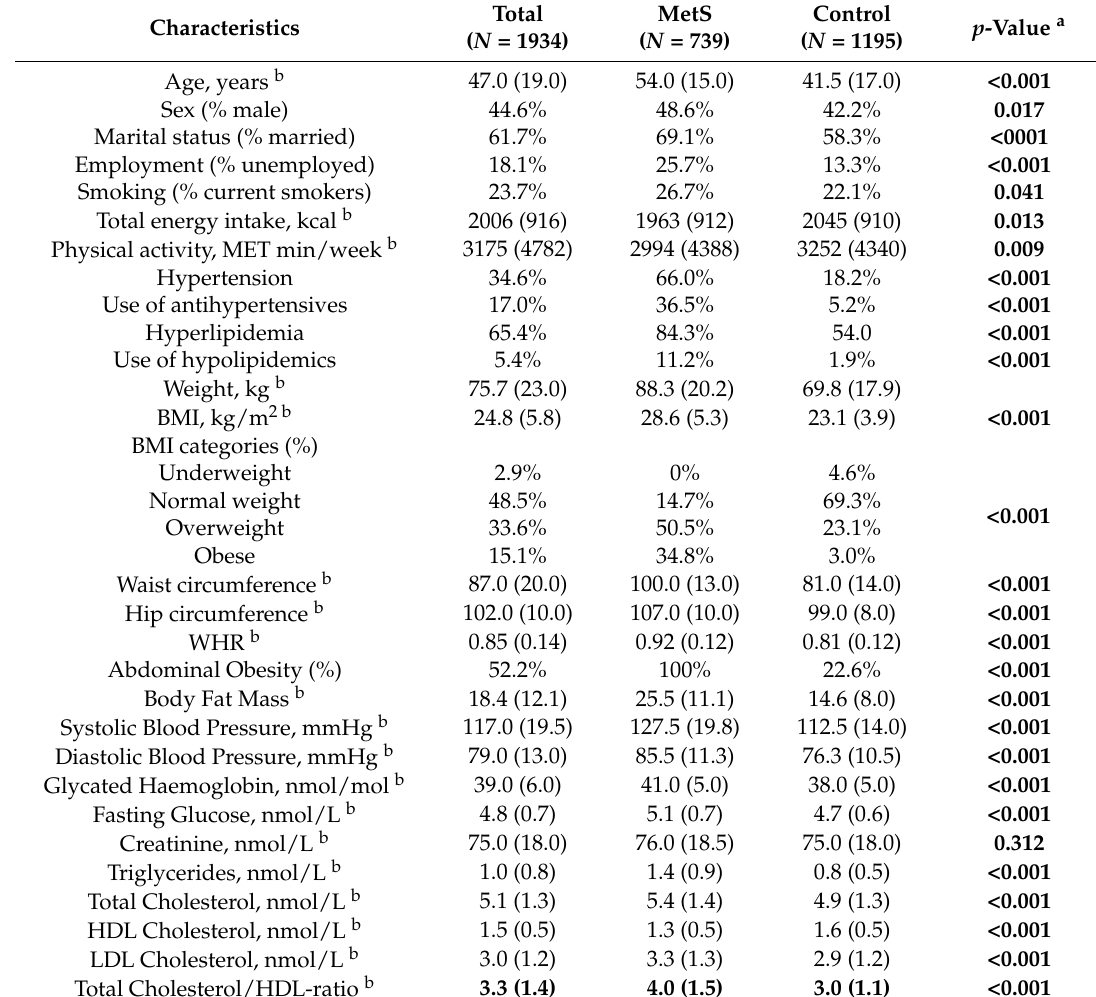
Table 1. Characteristics of study population and comparison between MetS patients and